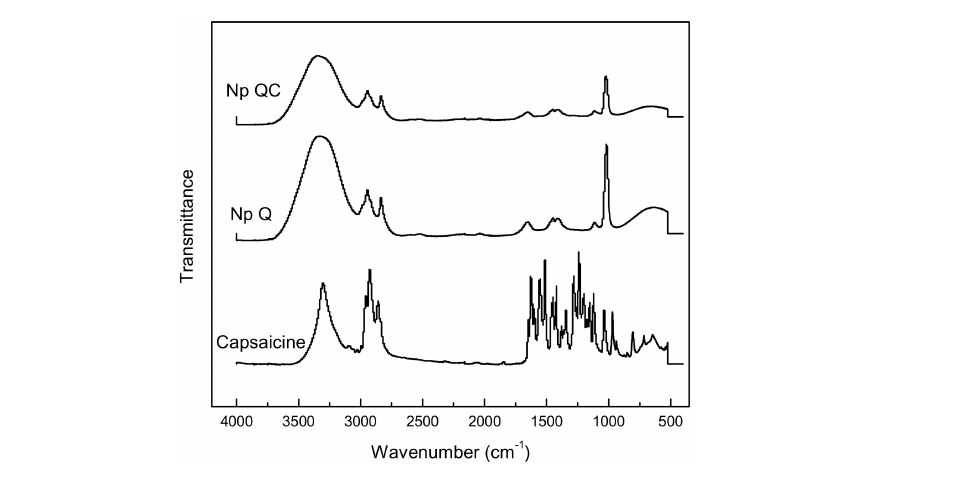
Figure 2. FTIR spectra of capsaicin, chitosan nanoparticles, and capsaicin loaded-chitosan nanoparti- cles.